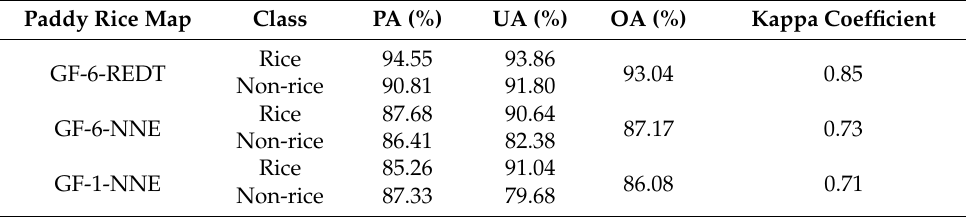
Figure 11. The comparison of three local paddy rice maps of Tianmen city (( a ) GF-6 image; ( b ) REDT method based on GF-6 rice map; ( c ) NNE method based on GF-6 rice map; ( d ) NNE method based on GF-6 rice map). Table 4. Confusion matrix of local accuracy assessment using Google Earth images.